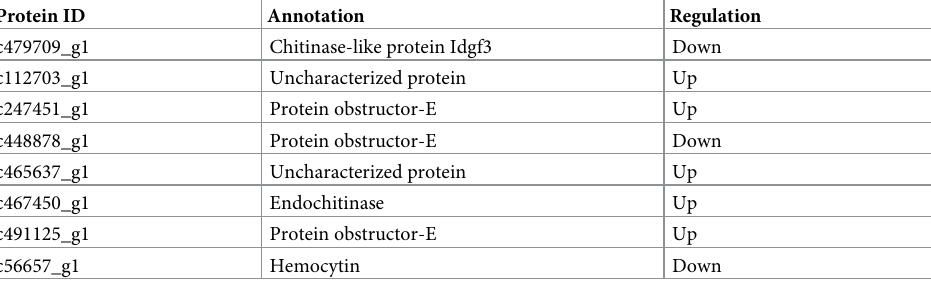
Table 2. DAPs involved with chitin metabolism in ND15 vs D15 comparison based on GO